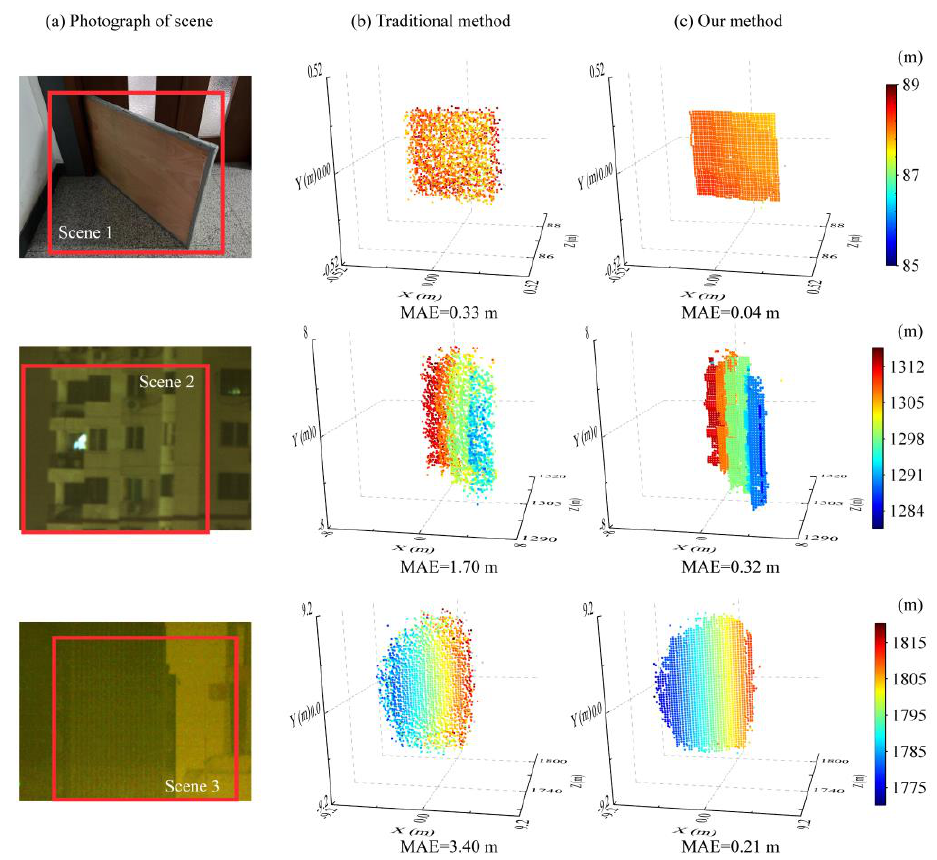
Figure 5. The 3D imaging result for scene 1 ( first row ), scene 2 ( second row ), and scene 3 ( third row ) at different distances. ( a ) The photograph of the target scene. ( b ) The reconstructed 3D image with the traditional MLE method. ( c ) The reconstructed 3D image with RSPE.